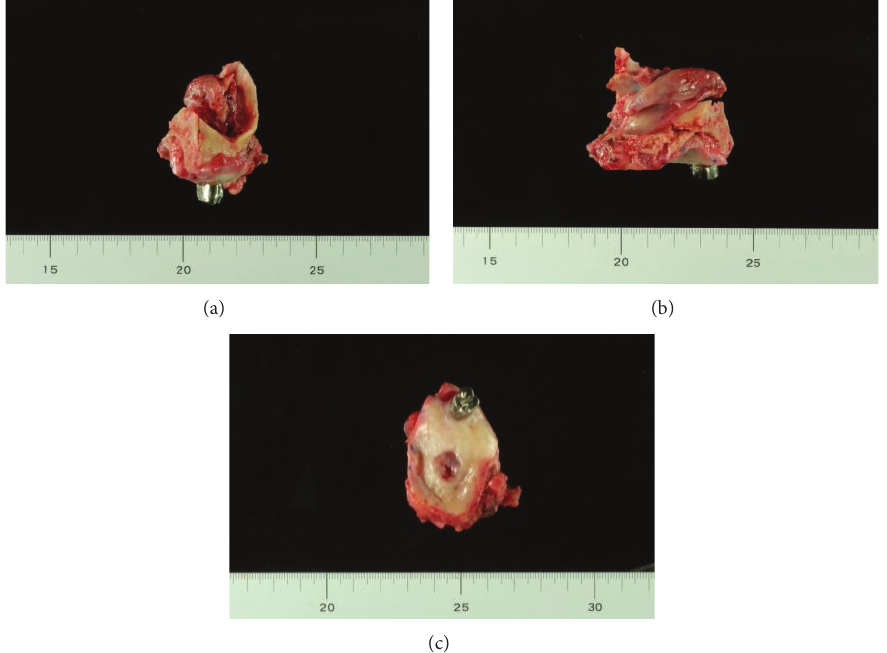
Figure 11: Resected specimens. (a) Frontal plane section. (b) Sagittal section. (c) Horizontal section.